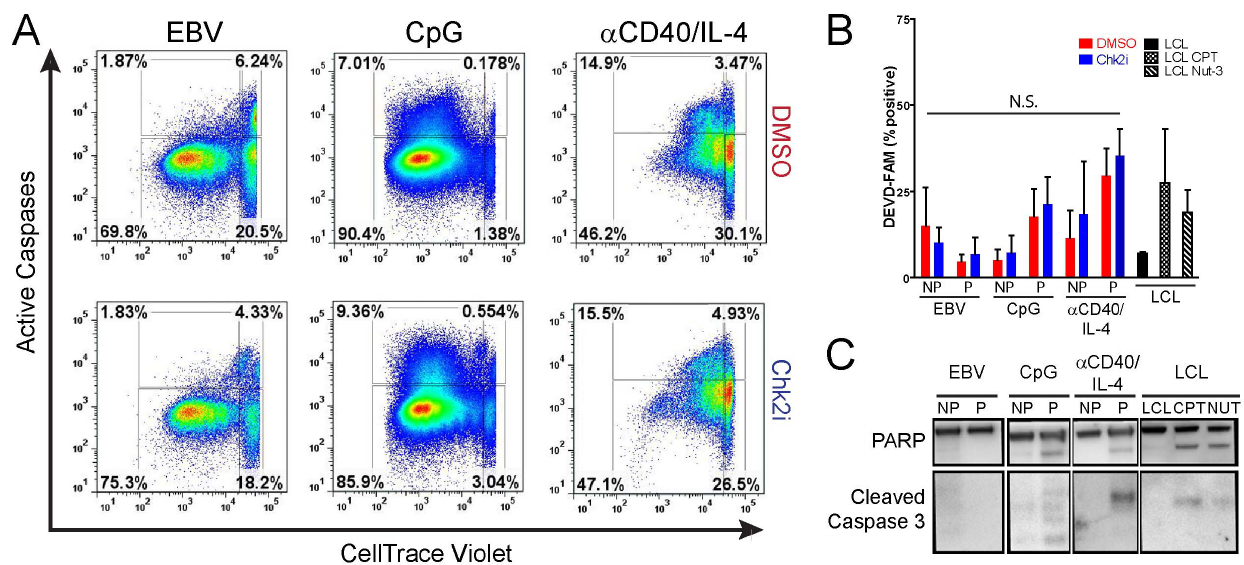
Figure 4. B-cell mitogens, but not EBV, induce caspase 3/7-dependent apoptosis. (A) Activated apoptosis in proliferating B cells treated with DMSO (top panels) or Chk2i (bottom panels) is measured with DEVD-FAM, a fluorescently labeled soluble caspase 3/7 inhibitor. FACS profiles represent CD19 + single cells. (B) Percent of active caspase-positive cells is plotted for non-proliferating (NP) or proliferating (P) EBV-infected, CpG treated, or a CD40/IL-4 treated CD19 + cells in the presence of DMSO (red) or Chk2i (blue). By comparing the Chk2i treated or DMSO treated conditions we found no statistically significant difference in the percentage of active caspase-positive cells by Student’s t test ( P -value . 0.05; N.S., Not Significant). Activation of caspases was compared to LCLs treated with 15 m M camptothecin (CPT) or 10 m M Nutlin-3 (Nut-3). (C) Cleavage of caspase targets (PARP and self-processing of caspase-3) revealed by western blot analysis of sorted non-proliferating (NP) or proliferating (P) EBV-infected or mitogen-stimulated B